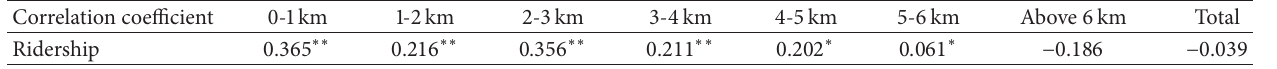
Table 1: Correlation analysis of population per distance band and ridership.